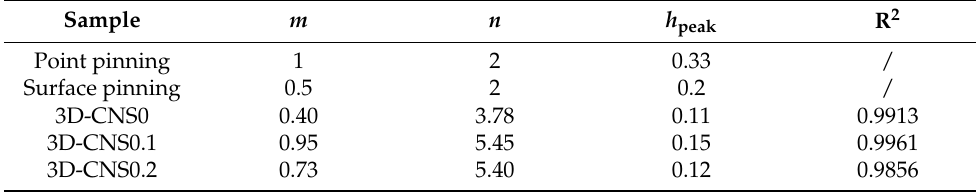
Table 3. Comparison of fitting values of Hughes